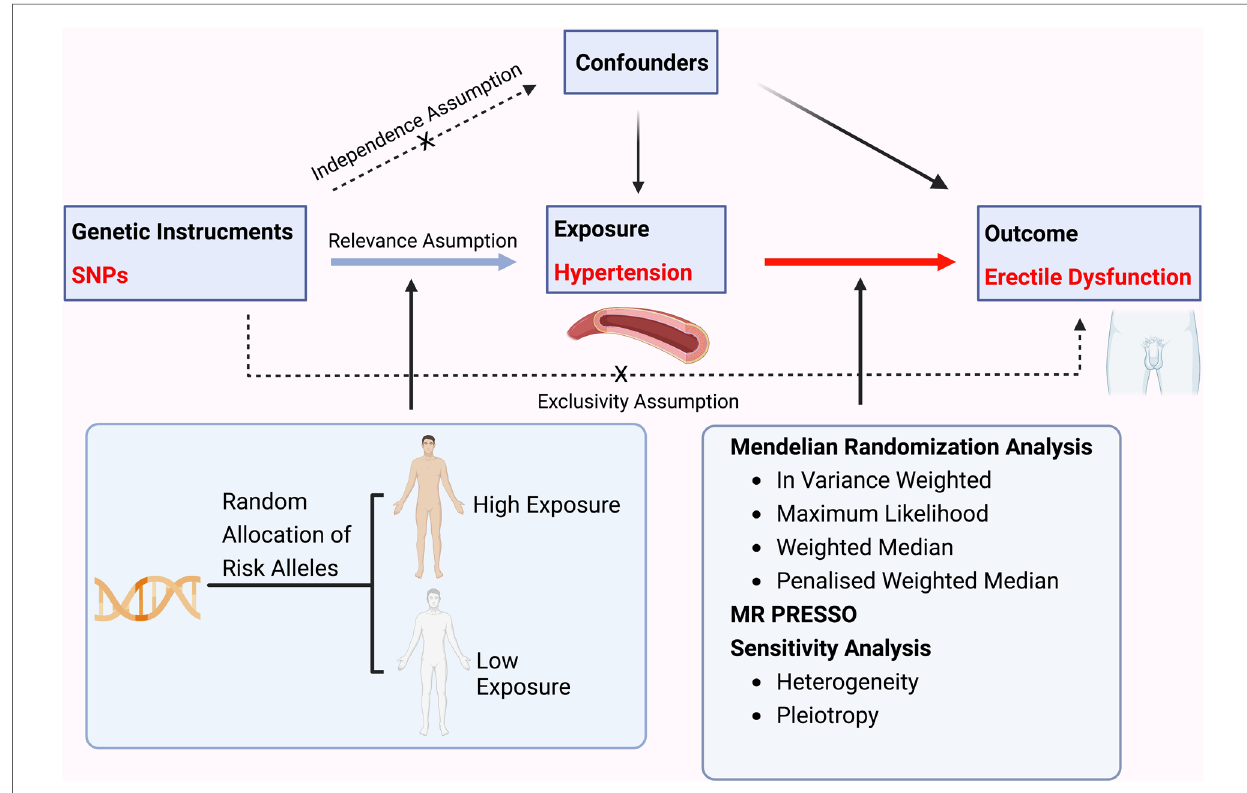
FIGURE 1 A fl ow chart illustrating the causality of the relationship between hypertension and erectile